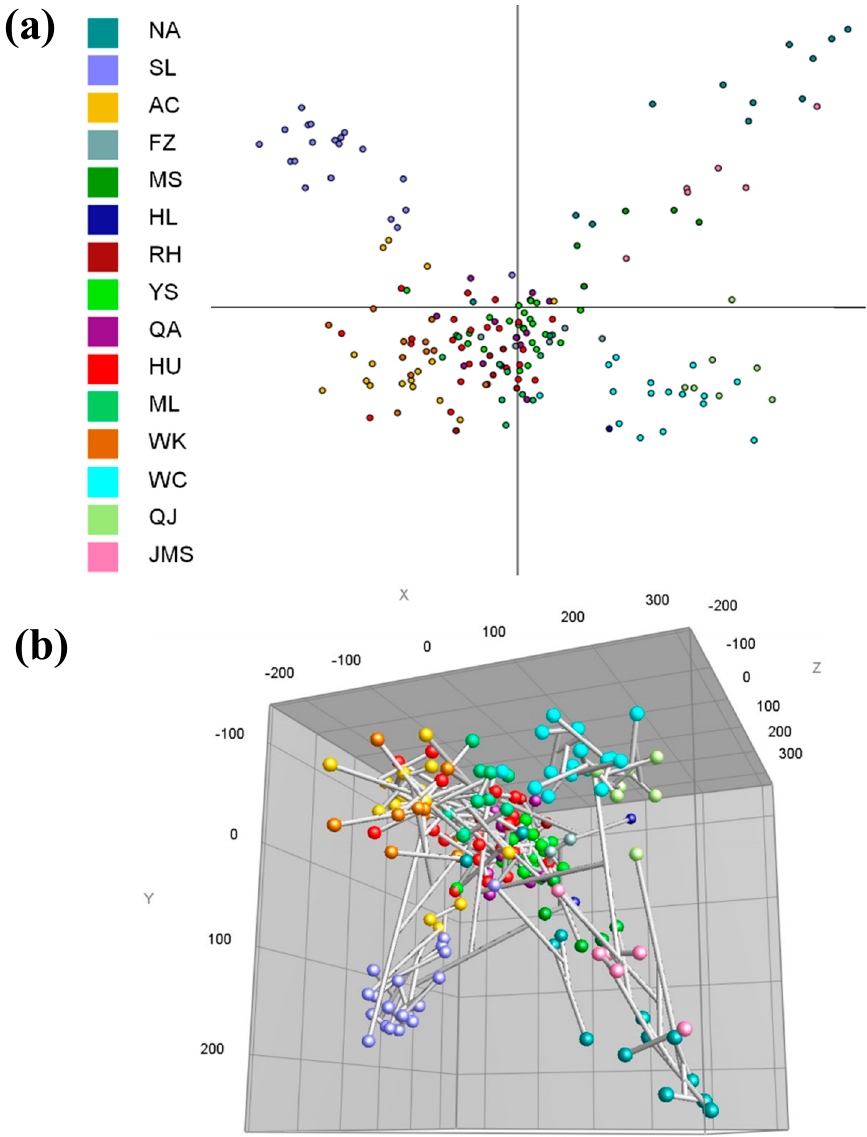
Figure 5. Principal coordinates analysis (PCoA) plots produced from P. s. pv. syringae profiles identified from the 15 studied regions using BioNumerics V7.6 software Plan view ( a ). An ideal combination for joint evaluation of tree graphs and PCoA ( b ).